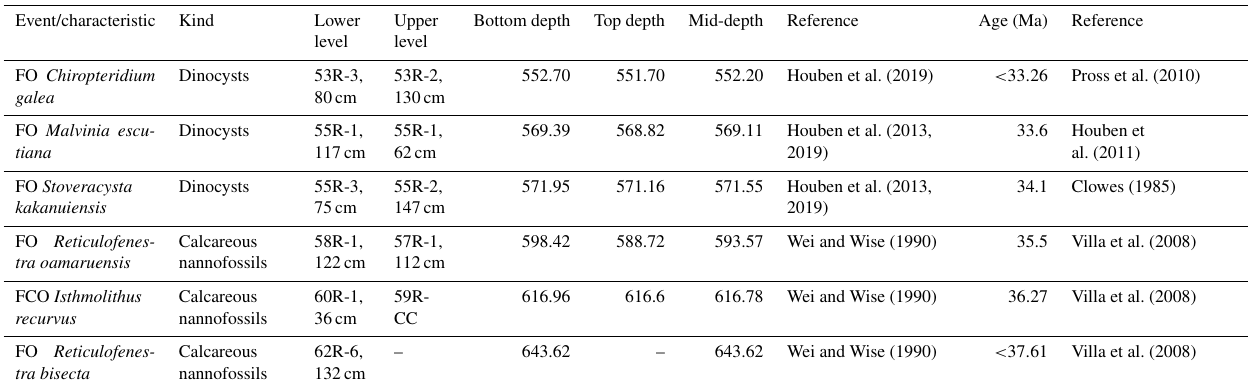
Figure 1. Modern-day geographical and tectonic setting of the study area, showing the location of ODP Site 696 on the south-eastern margin of the SOM (red circle) and litho-tectonic units superimposed for the Antarctic Peninsula and southern South America (modified after Elliot, 1988). Tectonic setting and features after Maldonado et al. (2014). APR, Antarctic-Phoenix Ridge; BB, Bruce Bank; Sea; DB, Discovery Bank; DvB, Dove Basin; EB, Endurance Basin; ESR, East Scotia Ridge; FP, Falkland Plateau; HB, Herman Bank; JB, Jane Basin; JBk, Jane Bank; OB, Ona Basin; PB, Powell Basin; PBk, Protector Bank; PrB, Protector Basin; SB, Scan Basin; SGM, South Georgia Microcontinent; SI, Seymour Island; SOM, South Orkney Microcontinent; SSIB, South Shetland Islands Block; TR, Terror Rise; WSR, West Scotia Ridge; and WSS, West Scotia Sea. (Adapted from López-Quirós et al., 2019, 2021.) Table 1. Revised age model for Ocean Drilling Program (ODP) Leg 113, Site 696, determined by calcareous nannofossil and dinoflagellate cyst biostratigraphy (FO: first occurrence; FCO: first common